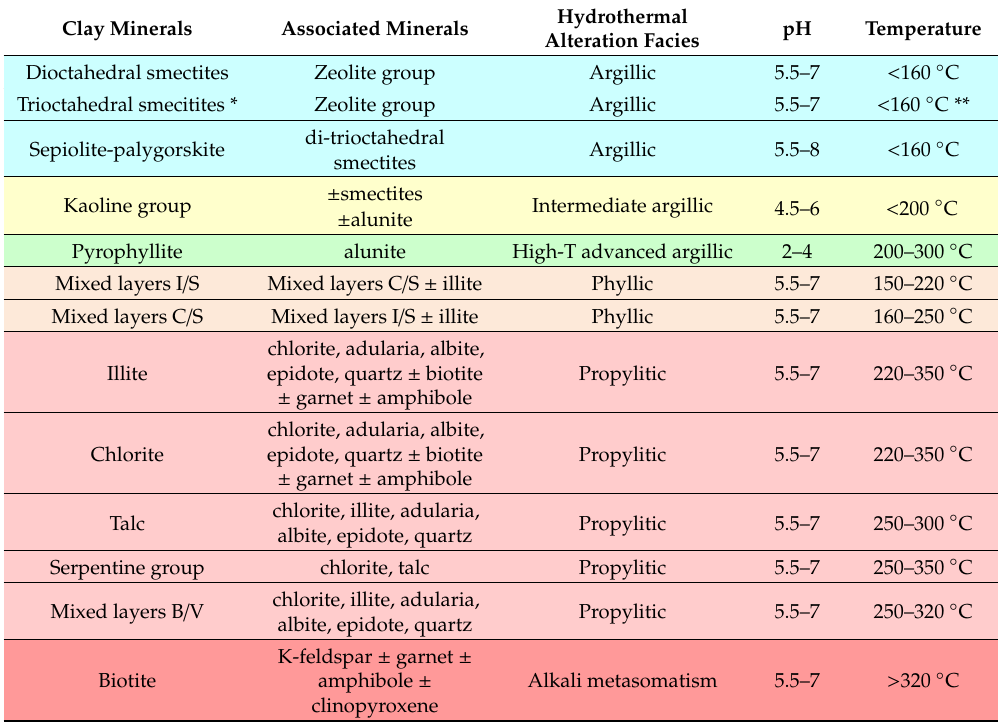
Table 2. Clay minerals typically present in hydrothermal environment as a function of alteration facies, associated minerals, and indicative pH and temperature of formation (see text, Section 3, for discussion and